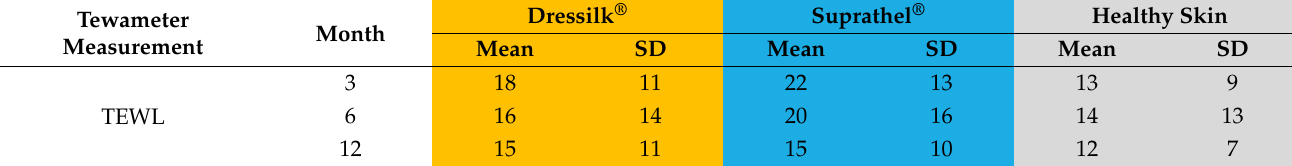
Table 4. Transepidermal water loss (TEWL) in g/h/m 2 after 3, 6 and 12 months of areas treated initially with Suprathel, Dressilk and the uninjured control